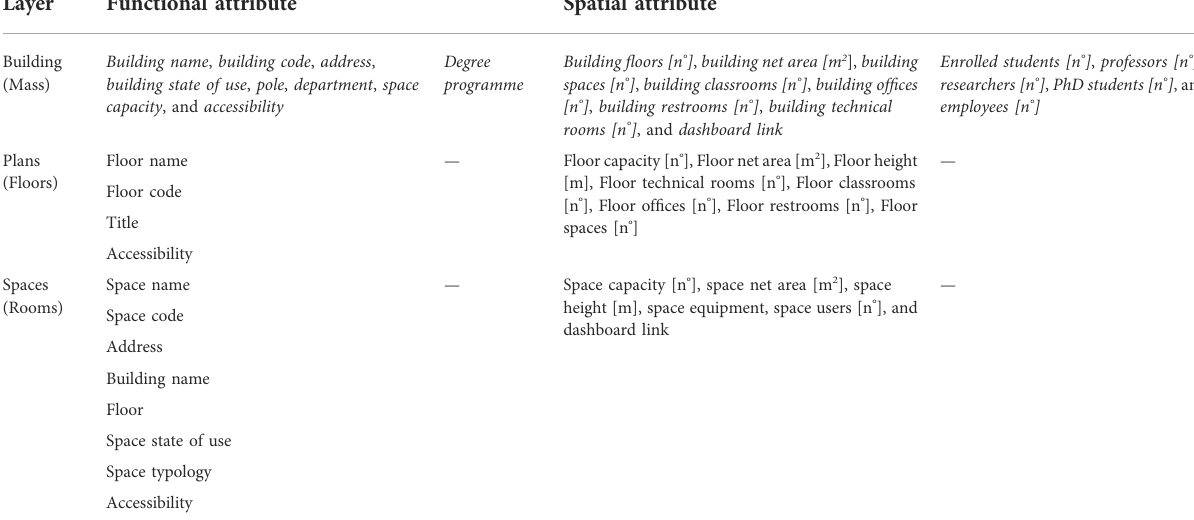
TABLE 5 Centralized database information layer with related spatial and functional attributes.